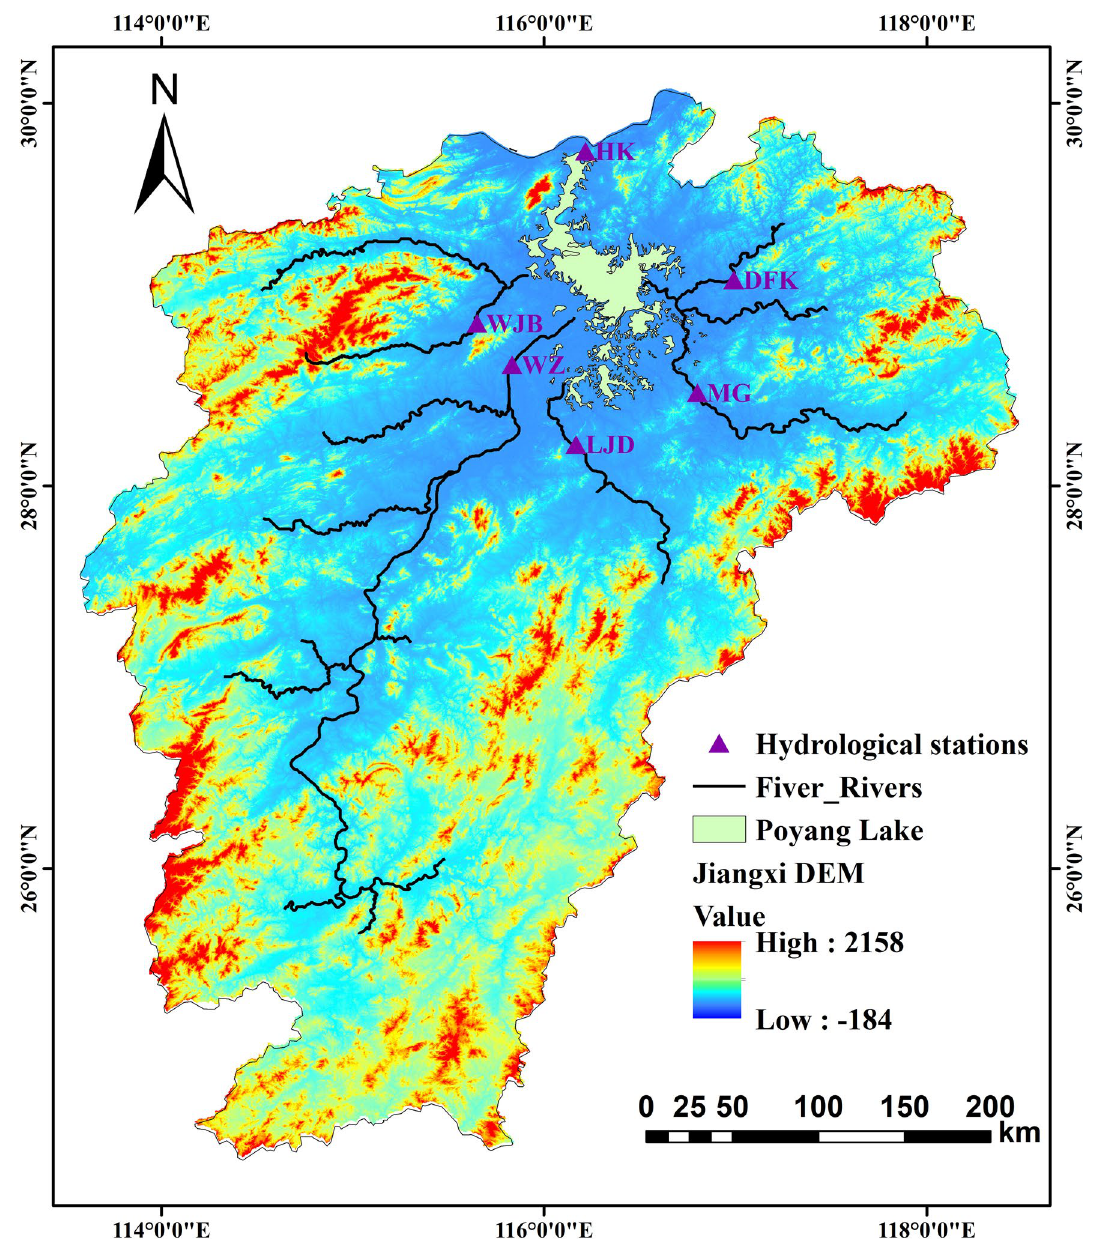
Fig. 6 Geographical overview of Poyang lake